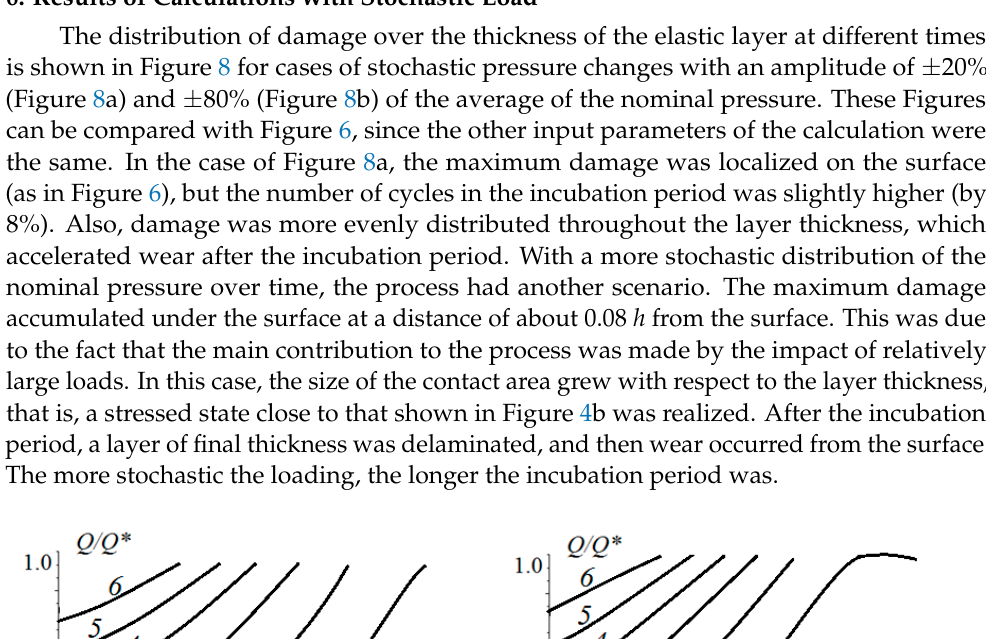
Figure 7. Displacement of the layer surface (wear kinetics). Effect of sliding velocity ( a ):